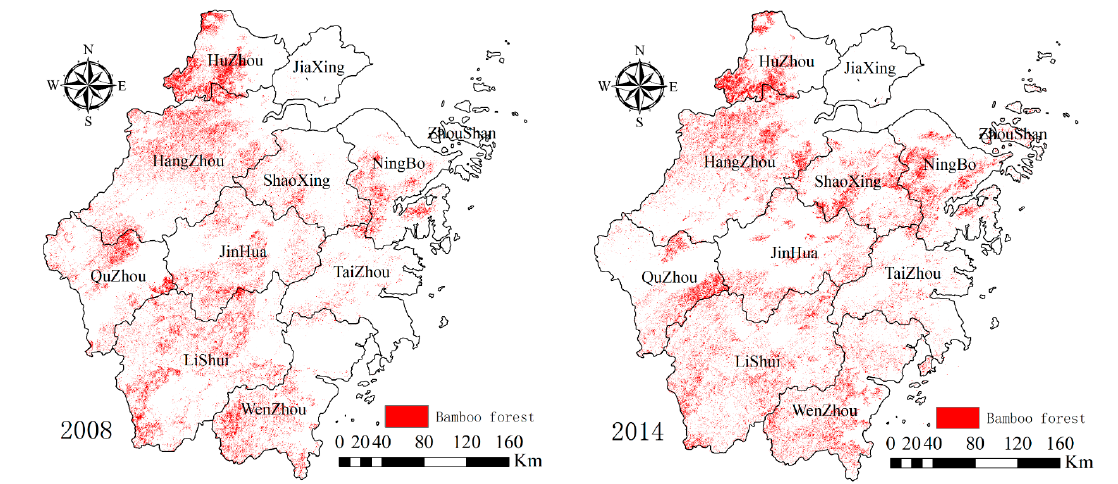
Figure 2. The bamboo forest information extraction in different years throughout Zhejiang Province. Table 4. Accuracy of classification and bamboo forest extraction in Zhejiang Province.